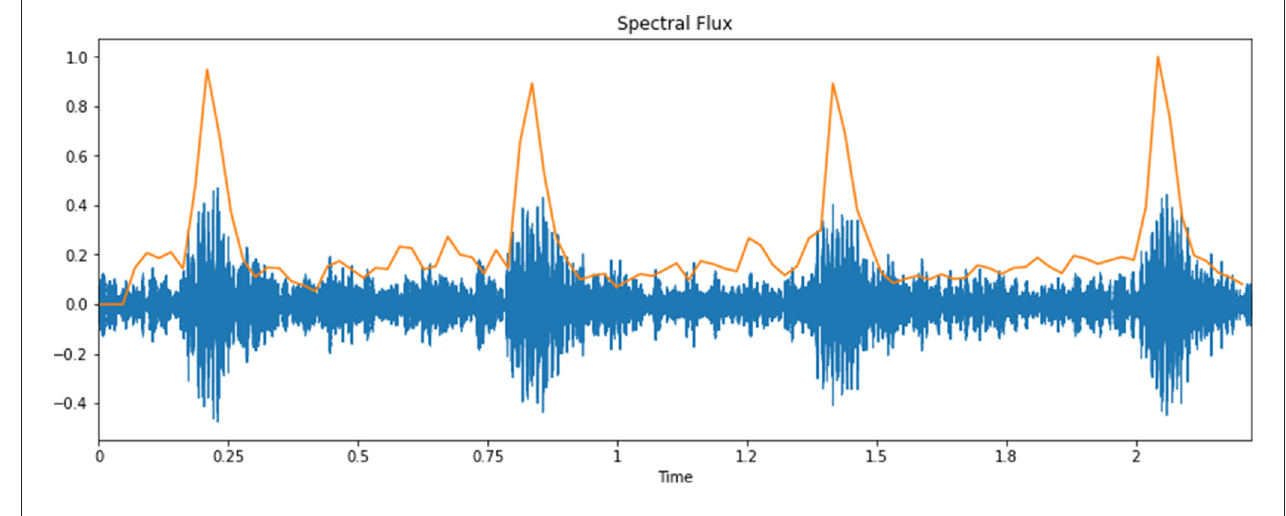
FIGURE 7 | Spectral flux of an infant cry’s audio signal.